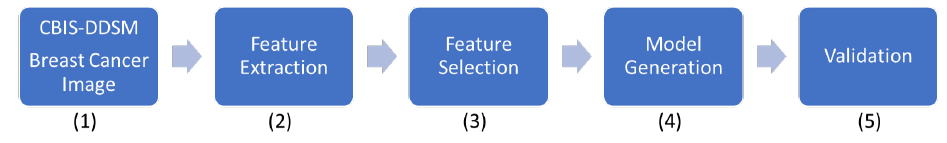
Figure 1. Block diagram of the proposed